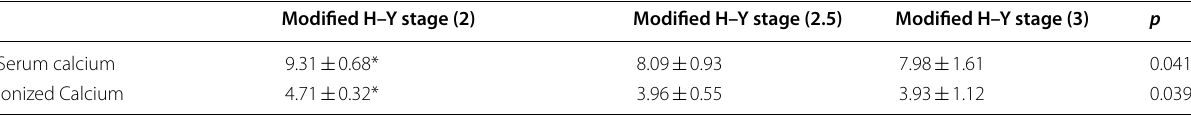
SD standard deviation, p < 0.05 is *(significant), Modified H–Y modified Hoehn and Yahr